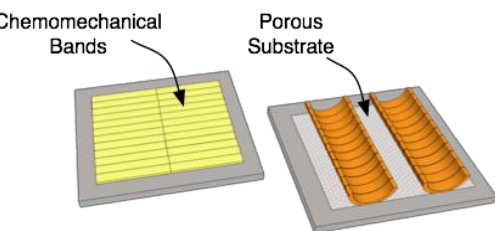
Figure 7. Concept variant inspired by troponin and